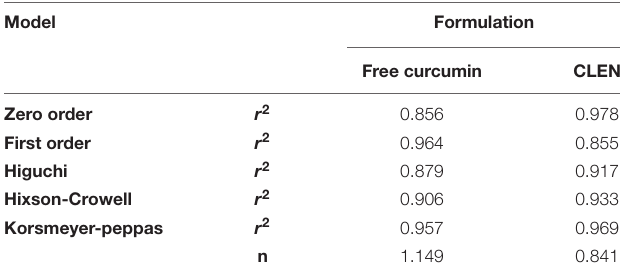
TABLE 1 | Linear correlation coefficients obtained for in vitro release data from various